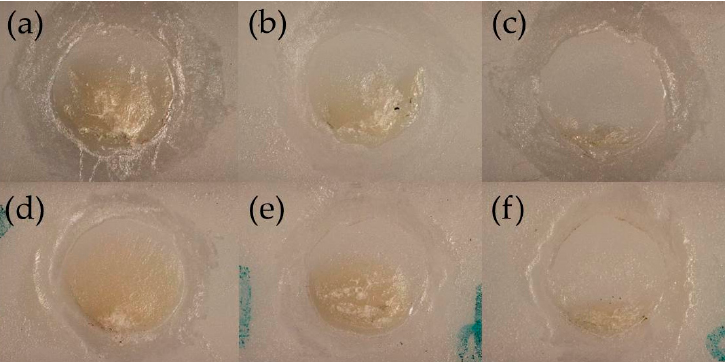
Figure 6. Microscope (10× magnification) of fractured specimen surfaces with different failure modes: ( a ) cohesive; ( b ) mixed; ( c ) adhesive failures in the uncoated group; ( d ) cohesive; ( e ) mixed; and ( f ) adhesive failures in the conditioner-coated